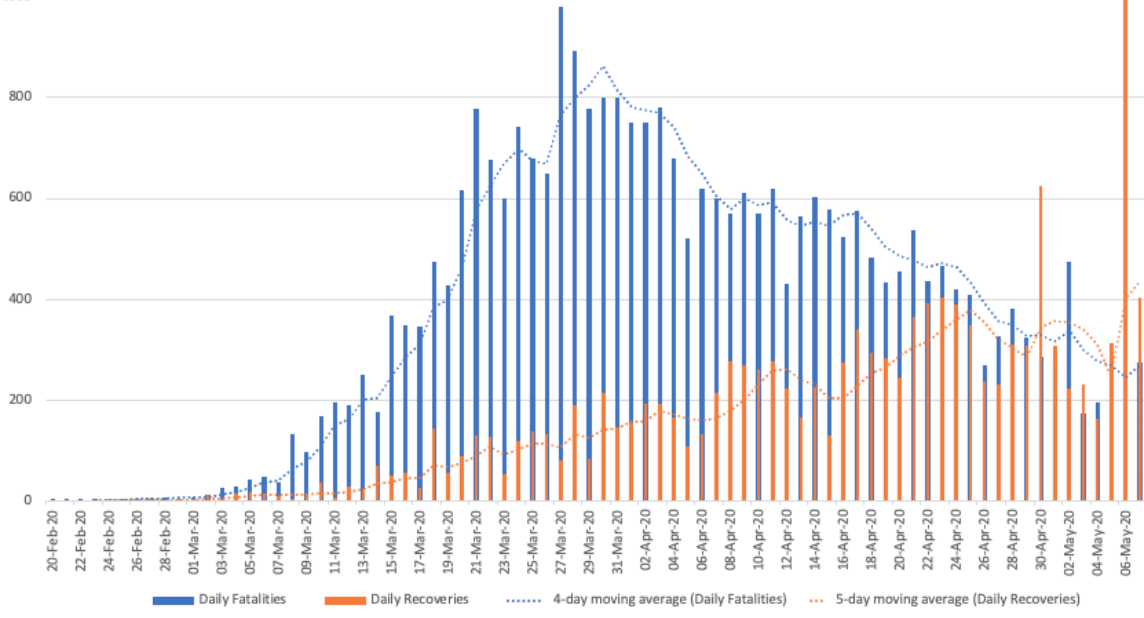
Figure 2. Graphical plot of COVID-19 cumulative total fatalities versus recoveries in Italy. COVID-19: coronavirus